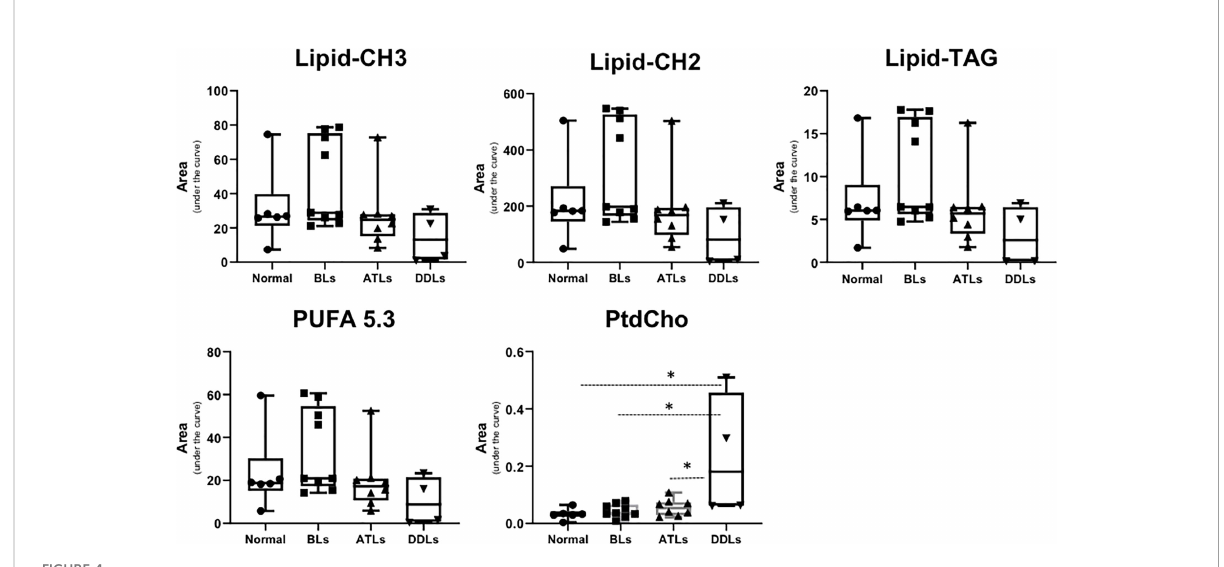
FIGURE 4 Bar plots showing semi-quantitative analysis of lipid metabolites obtained from organic fraction of normal fat tissue (n = 9), benign lipoma (BLs, n = 10), atypical lipomatous tumor (ALTs, n = 7), and dedifferentiated liposarcoma (DDLs, n = 8). Values represent mean± SE. Lipid-CH3; peak originate from – CH3 groups from all lipids at 0.9 ppm, Lipid-CH2; -CH2- group from total lipid at 1.3 ppm, Lipid-TAG; glycerol backbone of TAG lipids at 4.15 ppm, polyunsaturated fatty acids peak at 5.3 ppm and phosphatidylcholine (PtdCho) at 3.25 ppm. Values represent Mean ± SE. *P-values <0.05 are considered signi fi